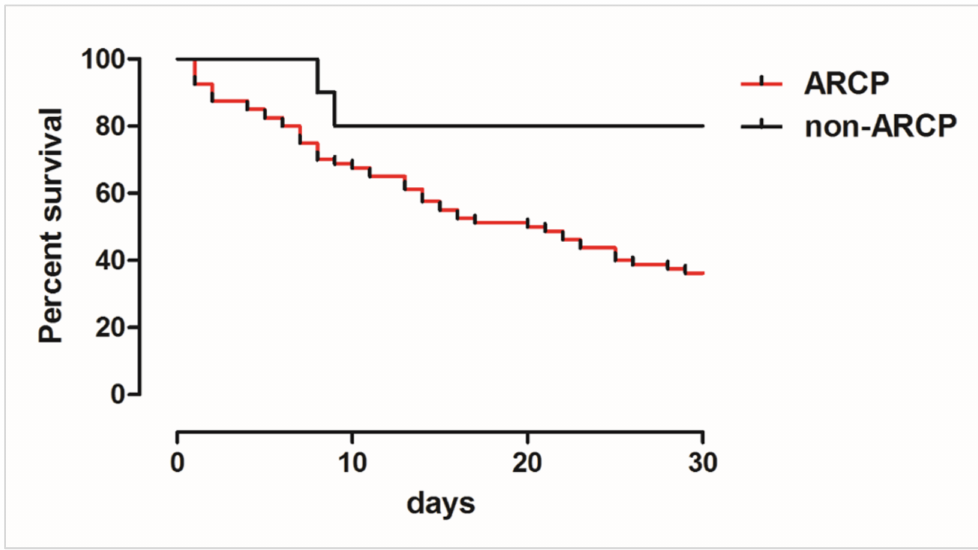
Figure 5. Kaplan–Meier curve for 30-day survival of candidemia patients infected with azole-resistant C. parapsilosis (ARCP) vs. non-ARCP ( p = 0.025). The curve was constructed and compared with the log-rank